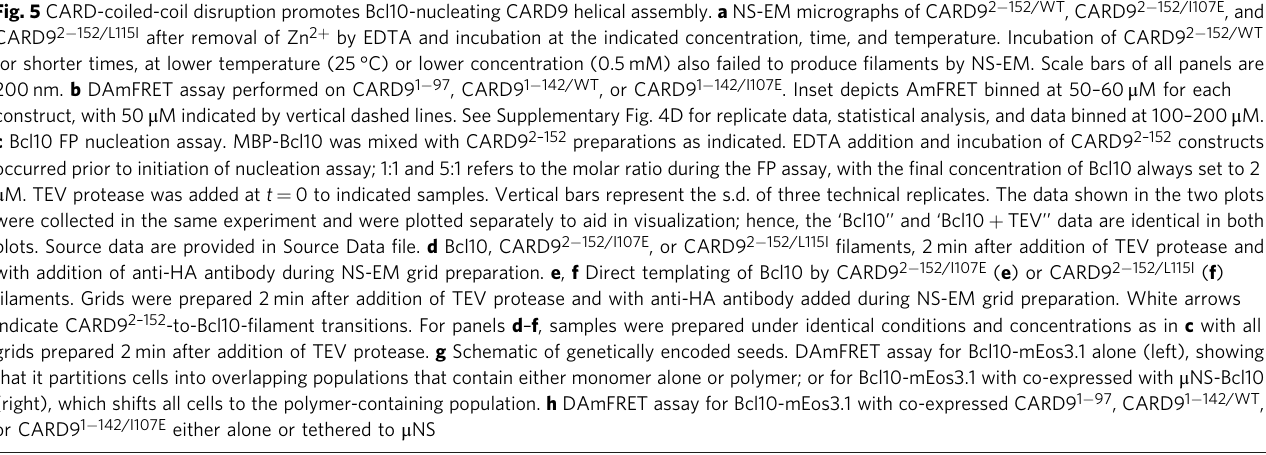
Fig. 5 CARD-coiled-coil disruption promotes Bcl10-nucleating CARD9 helical assembly. a NS-EM micrographs of CARD9 2 − 152/WT , CARD9 2 − 152/I107E , and CARD9 2 − 152/L115I after removal of Zn 2 + by EDTA and incubation at the indicated concentration, time, and temperature. Incubation of CARD9 2 − 152/WT for shorter times, at lower temperature (25 °C) or lower concentration (0.5 mM) also failed to produce fi laments by NS-EM. Scale bars of all panels are 200 nm. b DAmFRET assay performed on CARD9 1 − 97 , CARD9 1 − 142/WT , or CARD9 1 − 142/I107E . Inset depicts AmFRET binned at 50 – 60 μ M for each construct, with 50 μ M indicated by vertical dashed lines. See Supplementary Fig. 4D for replicate data, statistical analysis, and data binned at 100 – 200 μ